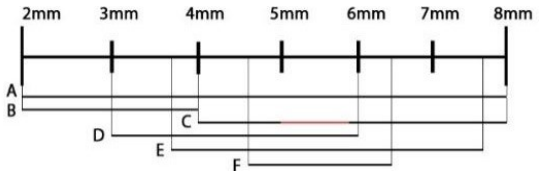
Figure 1. Human pupil diameter ranges to light and emotion: ( A ) total pupil range of the human eye; ( B ) average dilation range in daylight conditions; ( C ) average pupil dilation in low-level light; ( D ) average light dilation range; ( E ) emotive pupil dilation range; ( F ) the average pupil dilation frequency to emotion.